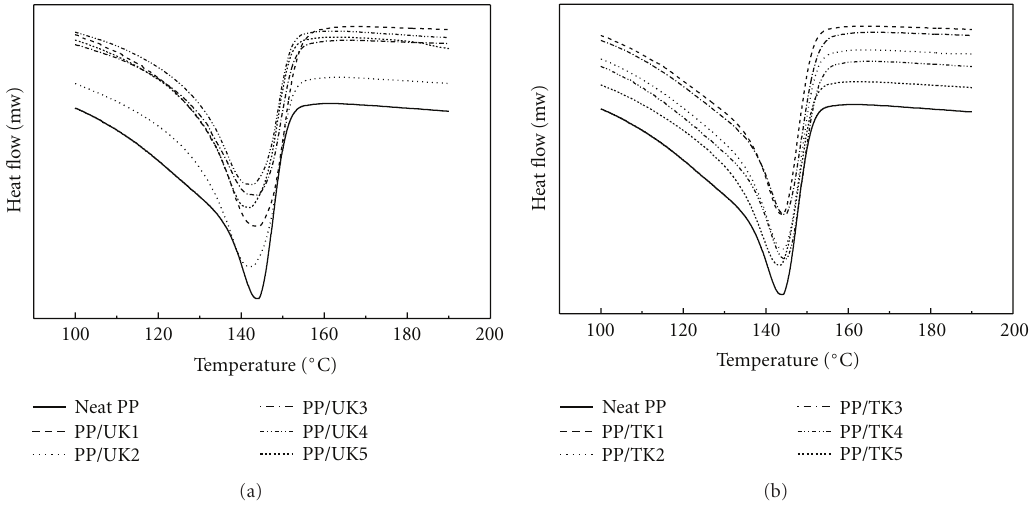
Figure 8: DSC heating thermograms of (a) PP/untreated kaolin and (b) PP/treated kaolin composites.